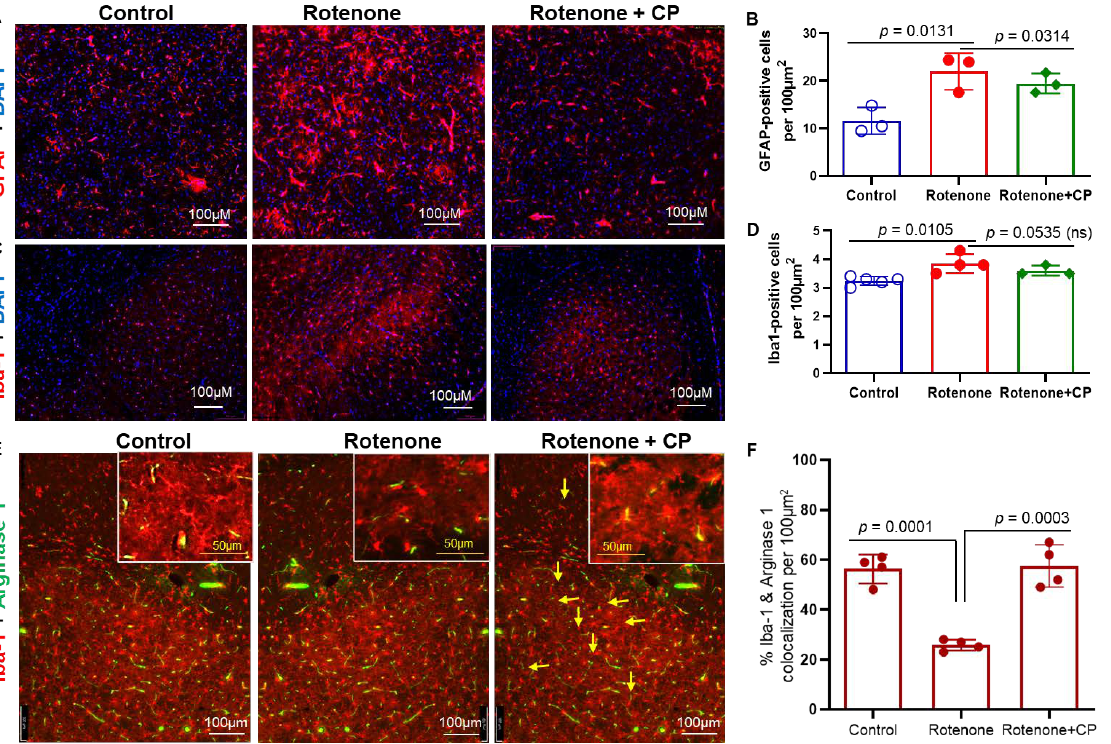
Figure 5. Activated astrocytes in the rat dorsal striatum following rotenone administration. Repre- sentative photomicrographs demonstrate GFAP-labeled astrocytes in the striatum in control, rotenone, and rotenone + CP treatment groups. ( A ) Rotenone administration conspicuously increased the number and size of the astrocytes in the striatum, and treatment of rats with CP decreased the number of reactive astrocytes. ( B ) Quantitative analysis by cellSens Imaging Software showed that the number of reactive astrocytes was significantly increased ( p = 0.0131) in rotenone vs. controls, whereas it was markedly decreased ( p = 0.0314) following CP treatment. N = 3. ( C , D ) Immunohistochemistry with Iba1 showed that the microglial population was significantly increased ( p = 0.0105) in the SN after rotenone administration of rats, which were not significantly changed ( p = 0.0535) following CP treatment. ( E ) Differentiation of microglia in rotenone rats after CP treatment. Colocalization (yellow, arrows) of Iba1 (red) and arginase 1 (green) in the dorsal striatum of CP-treated rats indicated differentiation of microglia into M2-type following calpain inhibition. N = 3–5. ( F ) Quantitative analyses of co-localized Iba-1+- and Arginase 1+-stained cells from Figure 5E. N = 4.